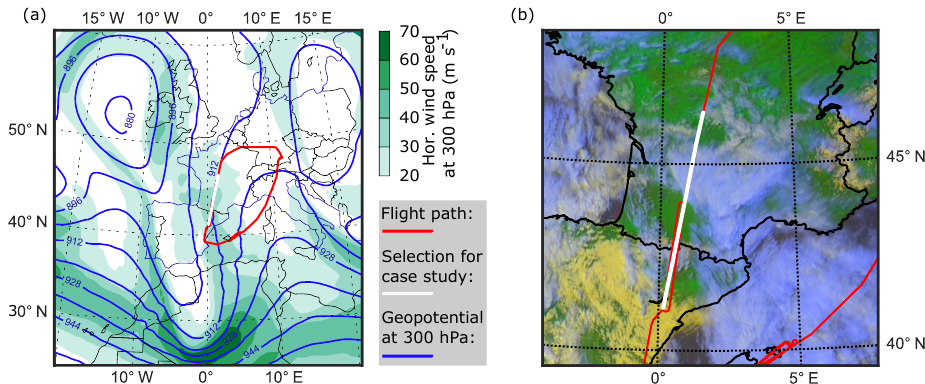
Figure 2. Meteorological situation on 29 March 2014 over western Europe: (a) ECMWF analysis data (12:00UTC) at 300hPa of geopotential (blue isolines) and horizontal wind speed (shaded green). (b) SEVIRI false-color image taken at 14:30UTC (see text). High ice clouds have a blue color, lower liquid clouds are yellow, cloud-free ground has green color. The path of the research flight is plotted in red and the flight leg used in the case study (14:16–14:58UTC) is marked white.